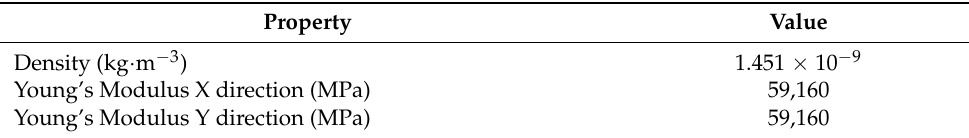
Table 4. Basic CFRP jacket parameters.